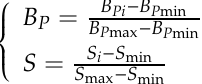
Figure 3. The 𝐵 (cid:3017) - S curves under condition of: ( a ) different radii; ( b ) different eccentricities. Figure 3. The B P - S curves under condition of: ( a ) di